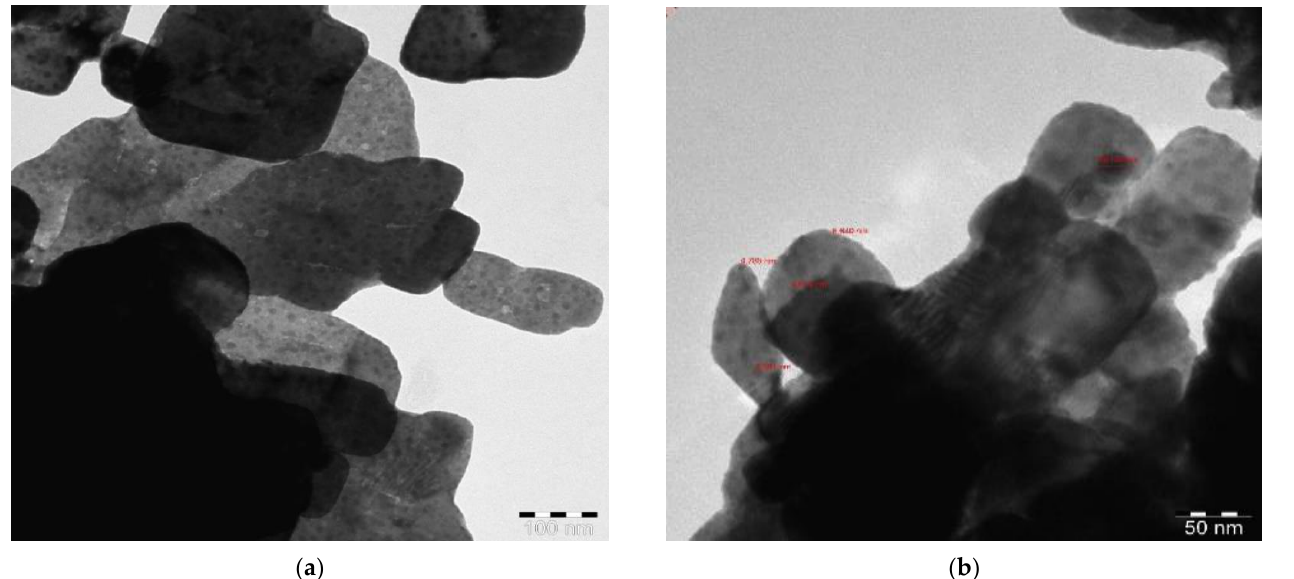
Figure 3. ( a , b ) The TEM results for the BiOI nanoparticles synthesized by sonochemical method at room temperature.